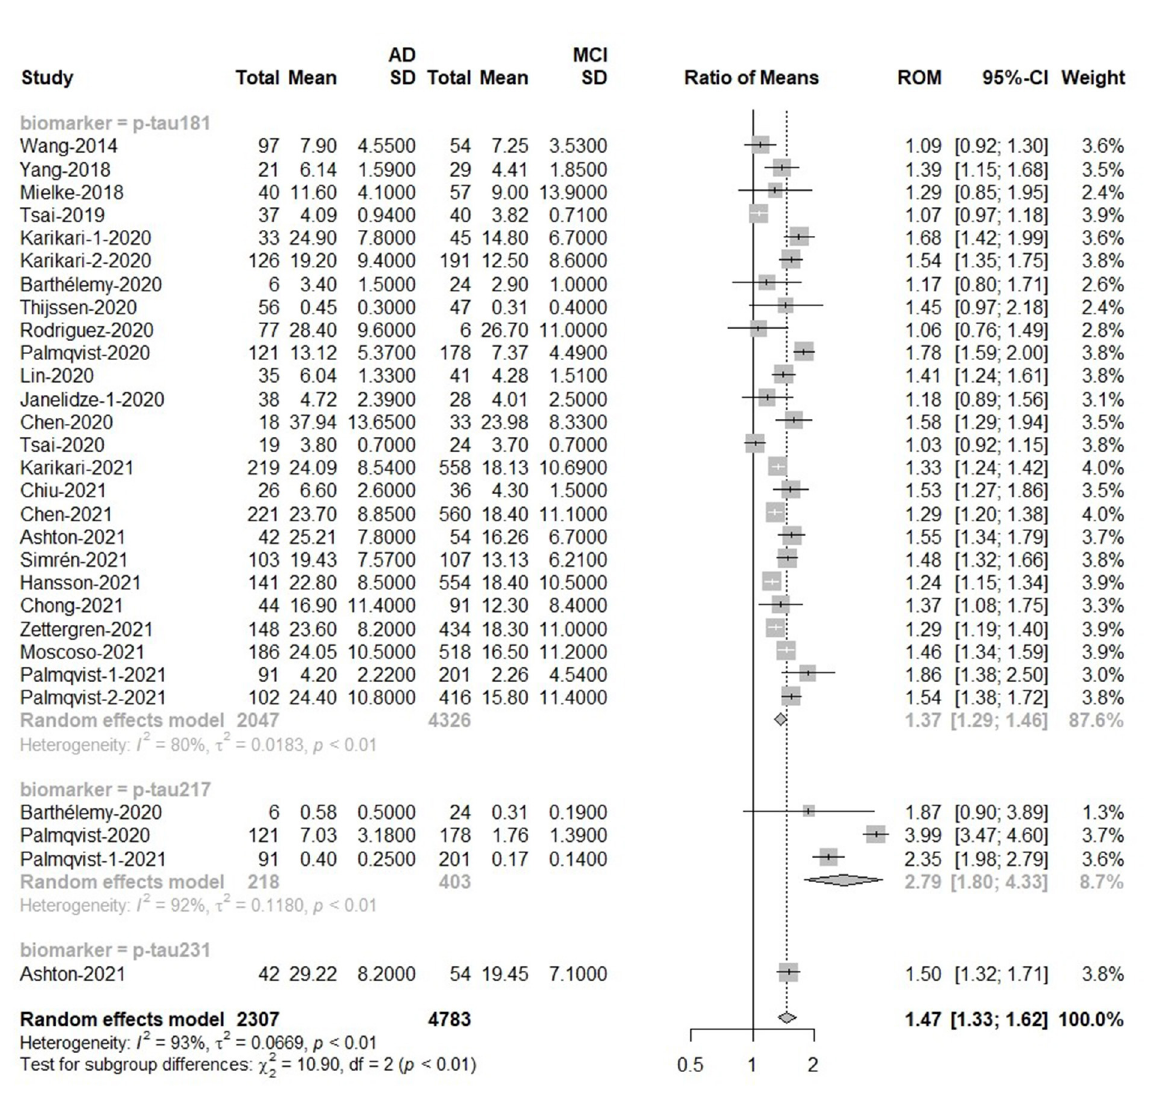
FIGURE5 AD to MCI ratio for blood p-tau: Forest plot of the ROMs (with 95%CI) for each tau subtype between AD and MCI. A ROM above one means that p-tau proteins were elevated in the AD groups. Total, total sample size; Mean, mean value; SD, standard deviation; ROM, ratio of means; CI, confidence interval; AD, Alzheimer’s disease; MCI, mild cognitive